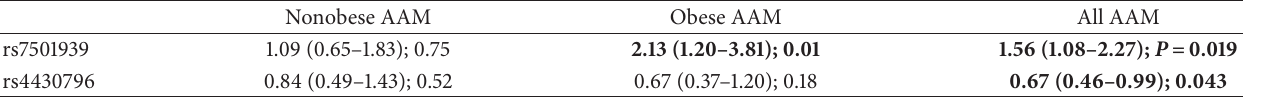
Table 4: rs7501939 and rs4430796 as PCa risk factors in AAM stratified by BMI. Nonobese AAM Obese AAM All AAM rs7501939 Statistically significant associations are shown in bold. Data is age